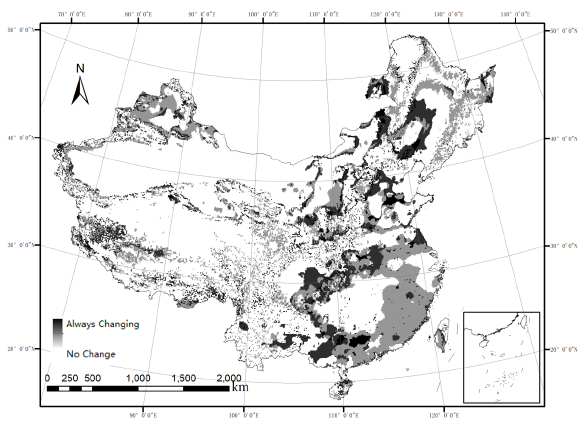
Figure 3. Climate type change in China (1979-2018)